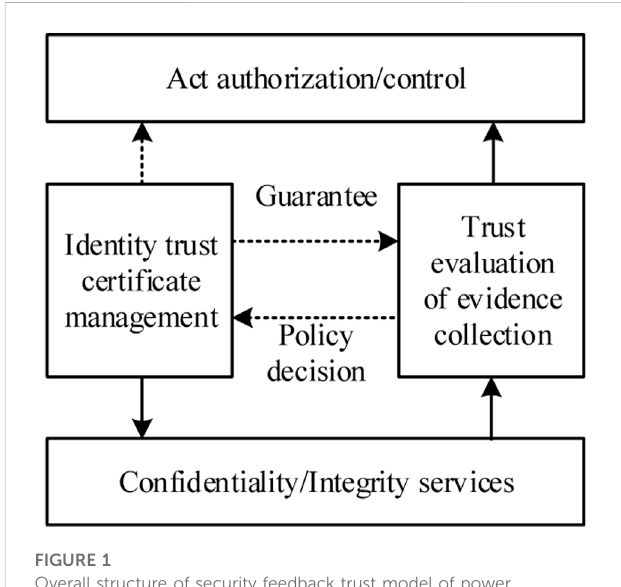
FIGURE 1 Overall structure of security feedback trust model of power network demand response